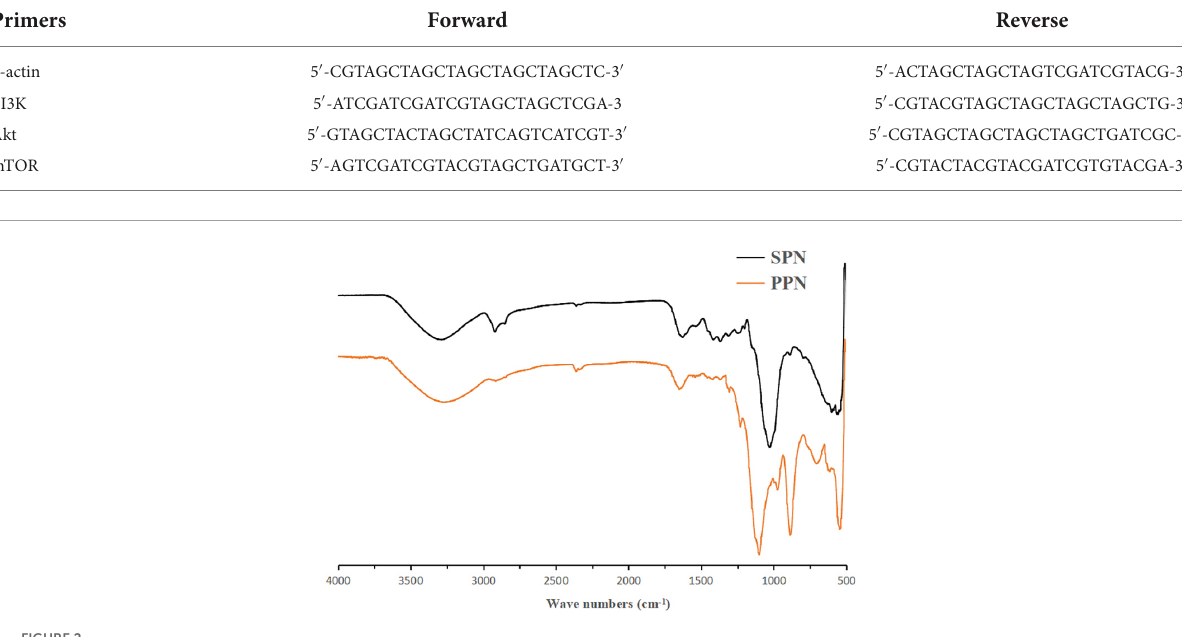
FIGURE2 FT-IR spectra of SPN and PPN.